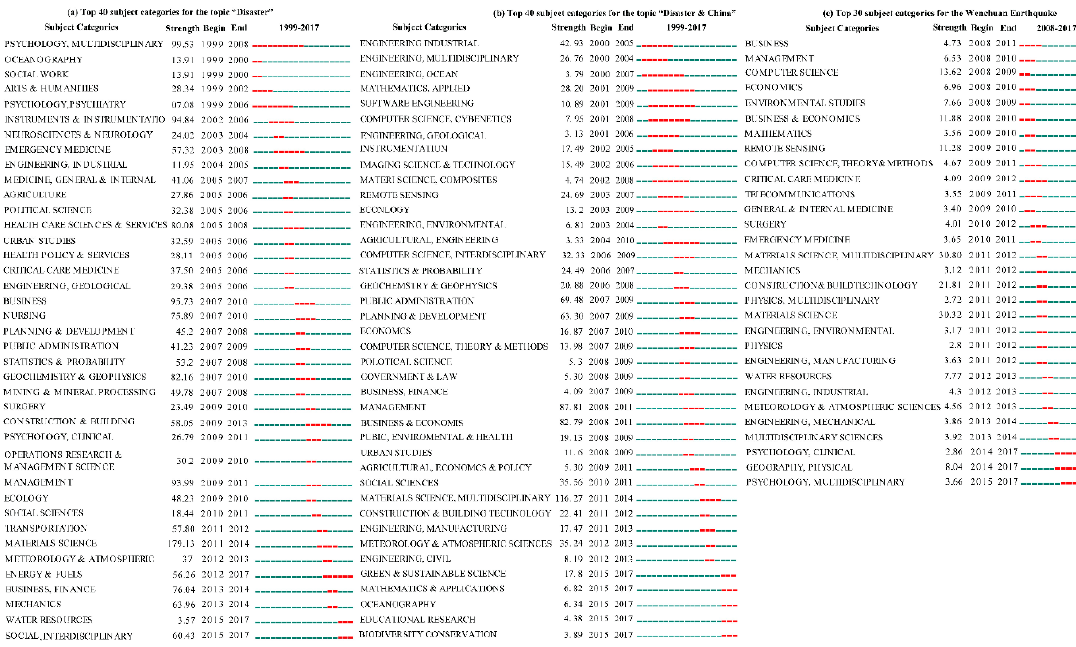
Figure 4. Summary of the subject categories with the strongest bursts (the popularity of one subject increased abruptly over time) for the “Disaster” topic in the Web of Science Core Collection. The blue line is the time interval, the red line segment is the duration of the burst for one subject, the beginning and end represent the boundaries of the time period of the burst, and the strength represents the degree of the burst.